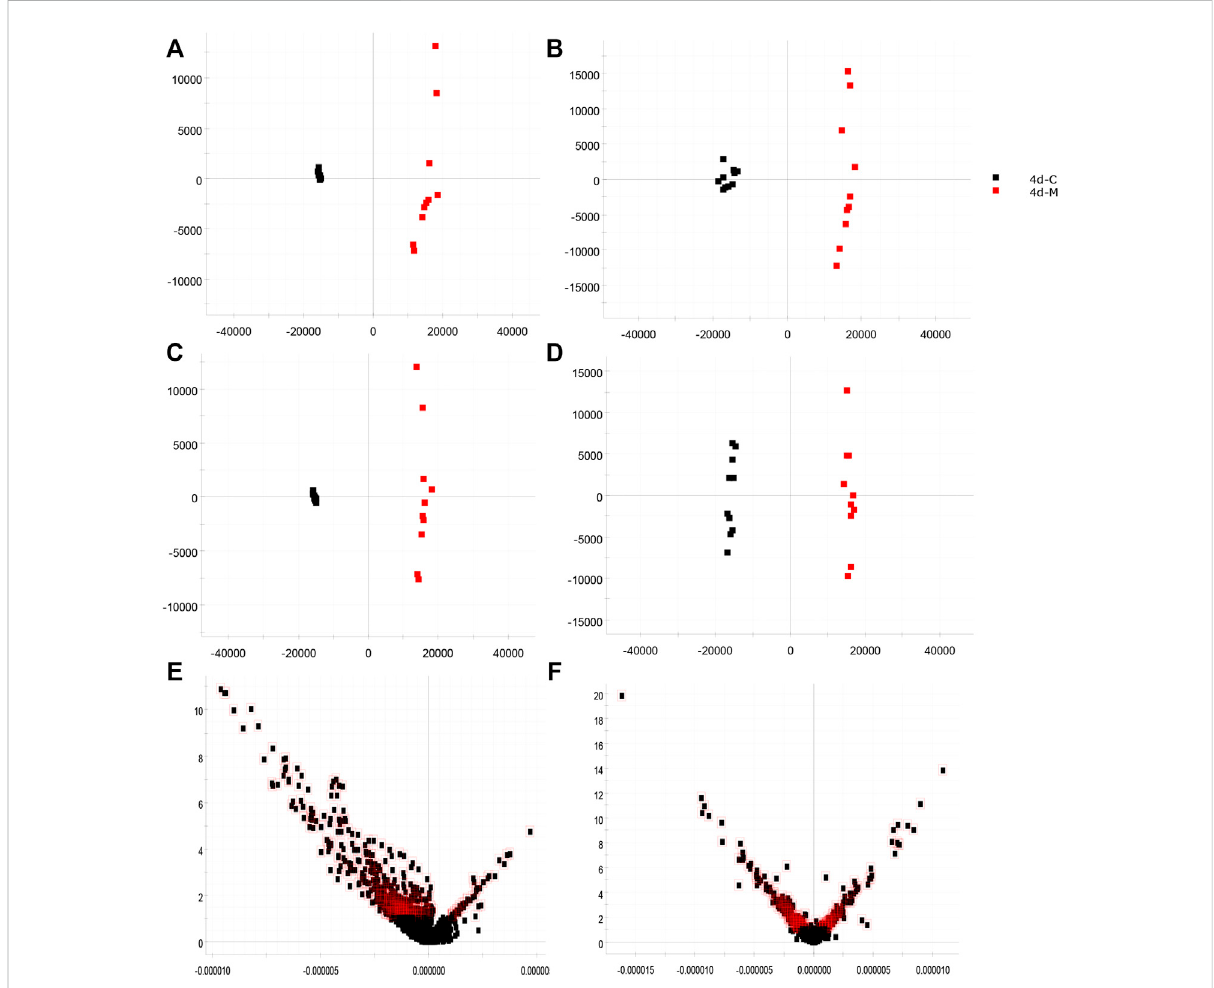
FIGURE 5 Identi fi cation of biomarkers from the insomnia model (red indicates the M group, n = 10; black indicates the C group, n = 10; red outline indicates VIP > 1). (A) PCA in the positive-ion mode; (B) PCA in the negative-ion mode; (C) OPLS-DA analysis in the positive-ion mode; (D) OPLS-DA analysis in the negative-ion mode; (E) VIP plot diagram in the positive-ion mode; (F) VIP plot diagram in the negative-ion